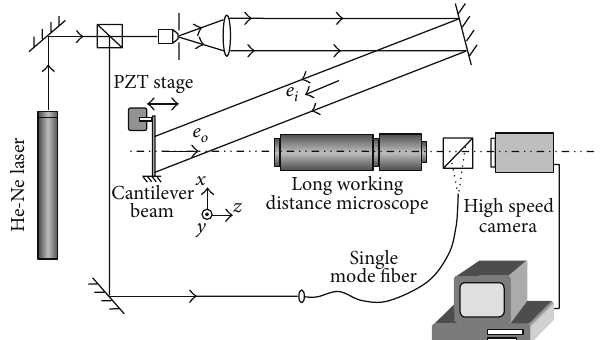
Figure 5: Schematic layout of an image-plane digital holographic microscope (reprint from